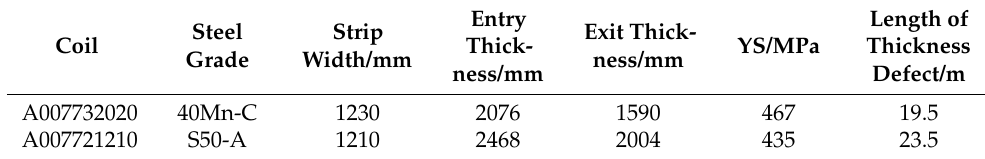
Figure 15. Thickness defect of the strip head after optimization. Table 5. The FGC strip after optimization.